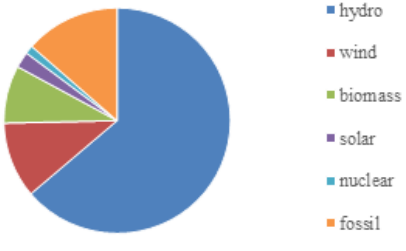
Figure 2. Brazilian energy matrix.